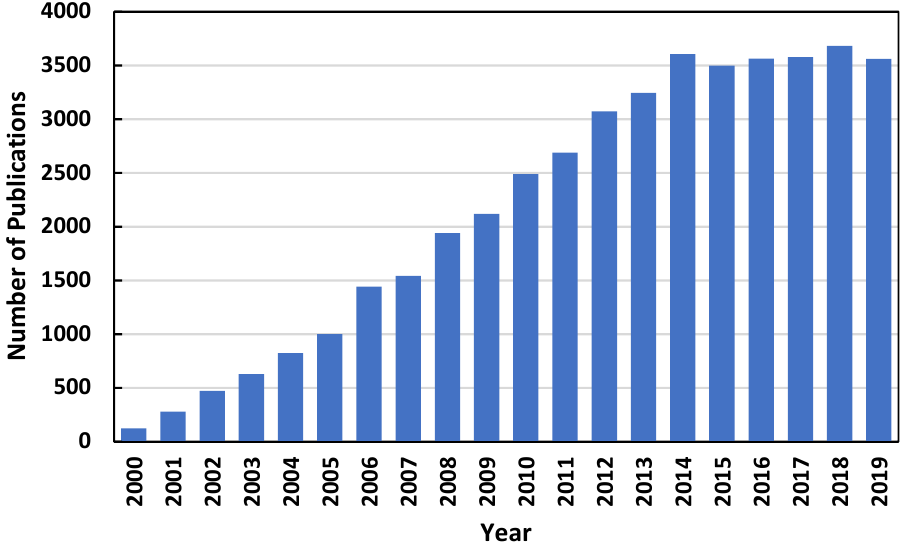
Figure 1. Web of Science record of ionic liquids related publications [10].